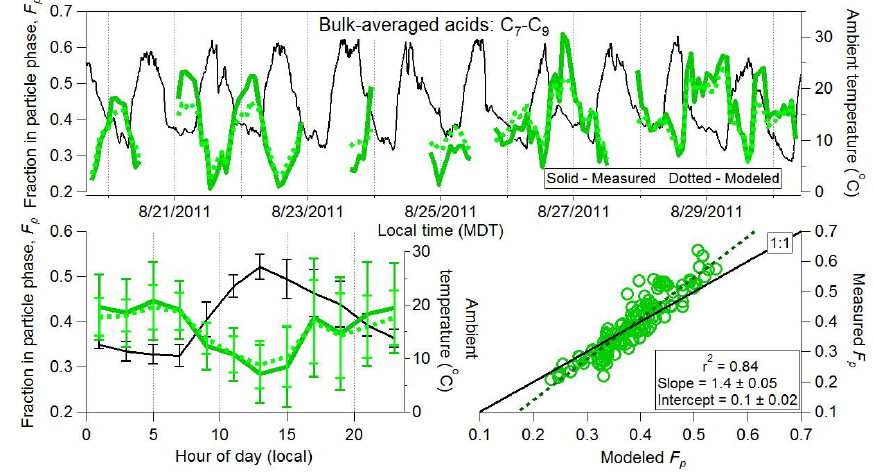
Fig. 7. Time series, diurnal cycle, and scatter plot of measured and modeled F p for C 7 –C 9 averaged bulk acids. Model uses excess oxygen as a hydroxyl group.